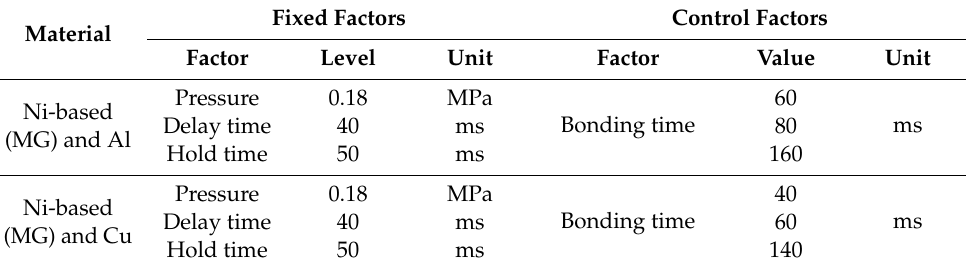
Table 1. Ultrasonic bonding experiment